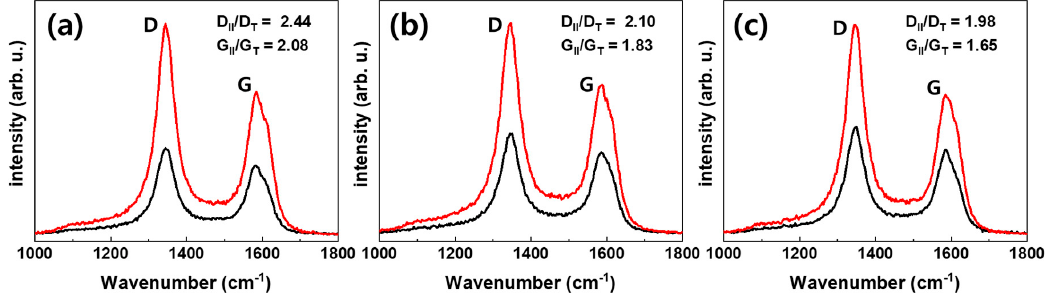
Figure 3. Raman spectra of multi-walled carbon nanotube (MWCNT) / PDMS composites; The red line measured at the incident light and the scattered light are parallel, and the black line measured at the incident light and the scattered light are perpendicular. ( a ) Aligned at R V = 4.5, ( b ) aligned at R V = 1.5 and ( c ) random array .